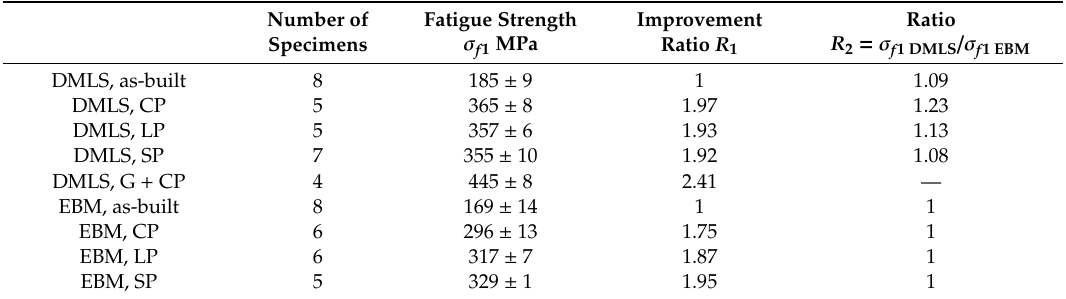
Table 1. Fatigue strength and improvement ratio of the as-built Ti6Al4V manufactured by DMLS and EBM and the Ti6Al4V manufactured by DMLS and EBM through cavitation peening (CP), laser peening (LP), shot peeing (SP), grinding (G), and cavitation peening after grinding (G +